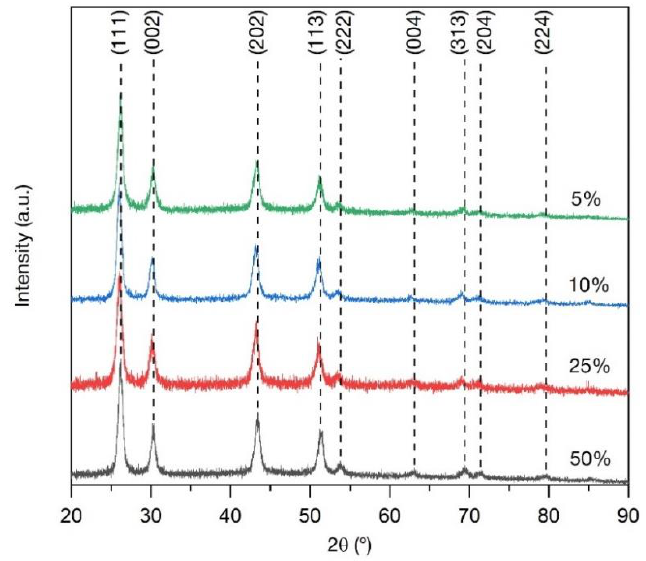
Figure 1. XRD patterns of the BaGdF 5 : x%Tb 3+ samples synthesized by the MW method (where x reported the legend).